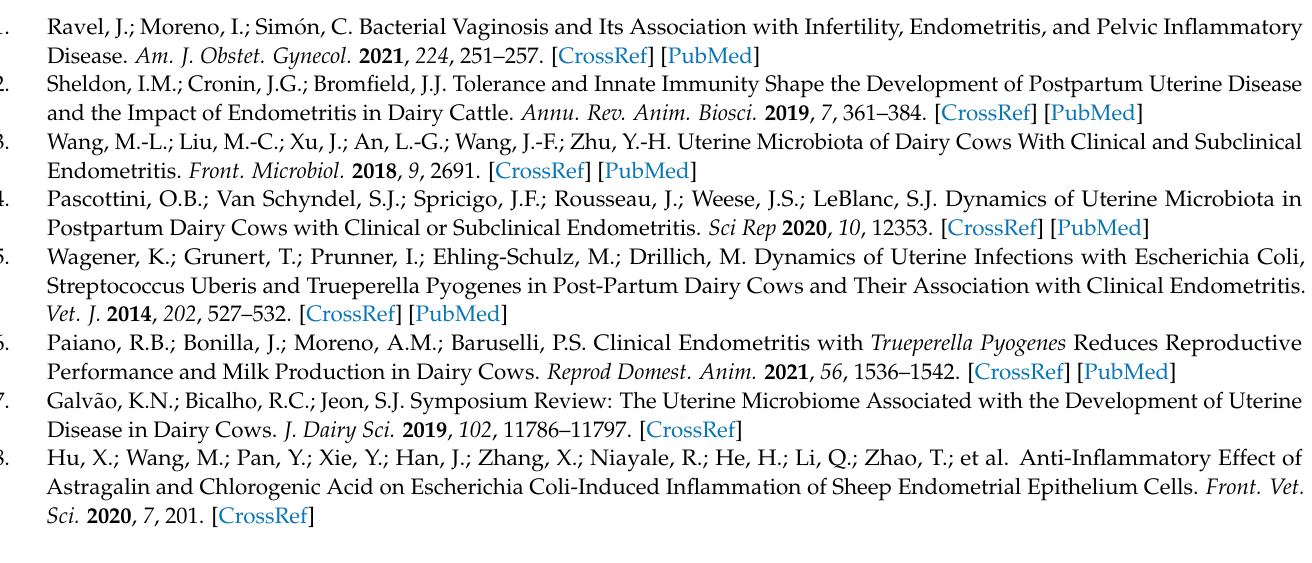
after the experiment; Table S1: The score criterion of uterine injury score; Table S2: Body temperature; Table S3: Pregnancy rate; Table S4: Pups per litter; Table S5: Weight per